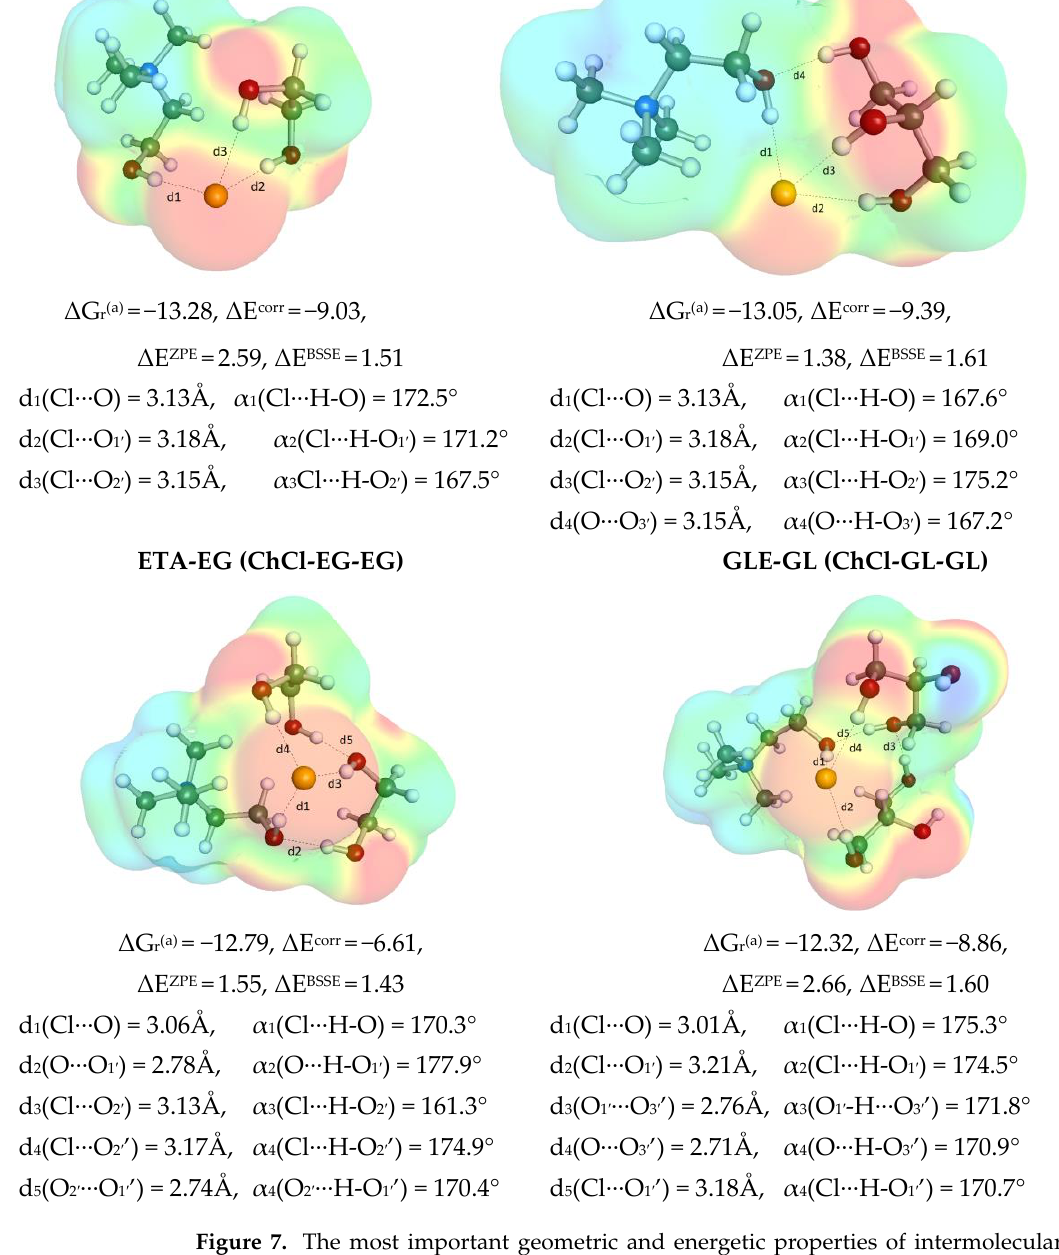
( b ) Figure 8. The values of edaravone affinity expressed as ( a ) activity- based Gibbs free energy (ΔG r(a) = − RTln(K a ); K a = K x ·K γ ) and ( b ) concentration- dependent values of Gibbs free energies (ΔG r(x) (x) = −RTln(K x ) in ethaline or glyceline (T = 298.15 K, ETA = ChCl:EG = 1:2, GLE = ChCl:GL = 1:2), where